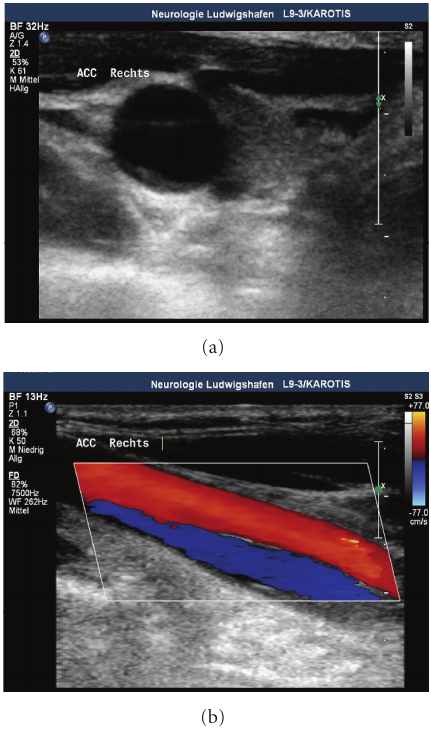
Figure 1: In native scan and with duplex mode, an irregular membrane crossing the vessel with a true and a false lumen was observed.